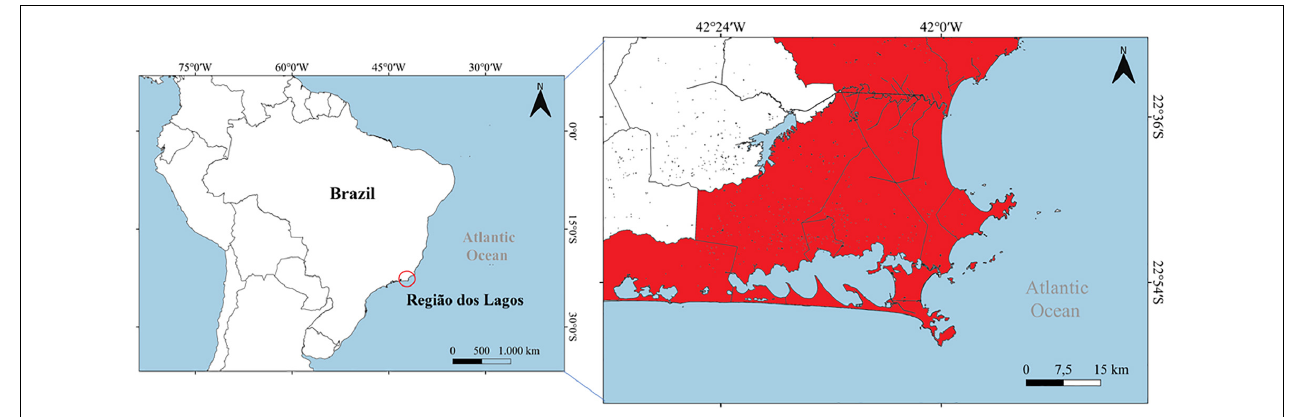
FIGURE 1 | Map of the study area of Região dos Lagos, eastern coast of the state of Rio de Janeiro, southeastern Brazil.